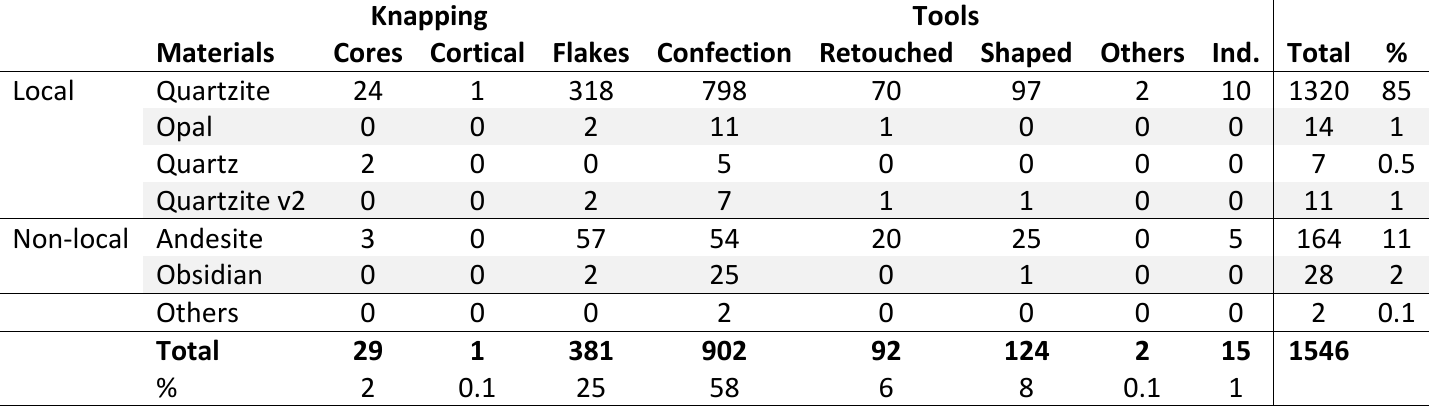
Table 1. Lithic materials of Laguna Media 7 classified following raw material and chaîne opératoire by-products.